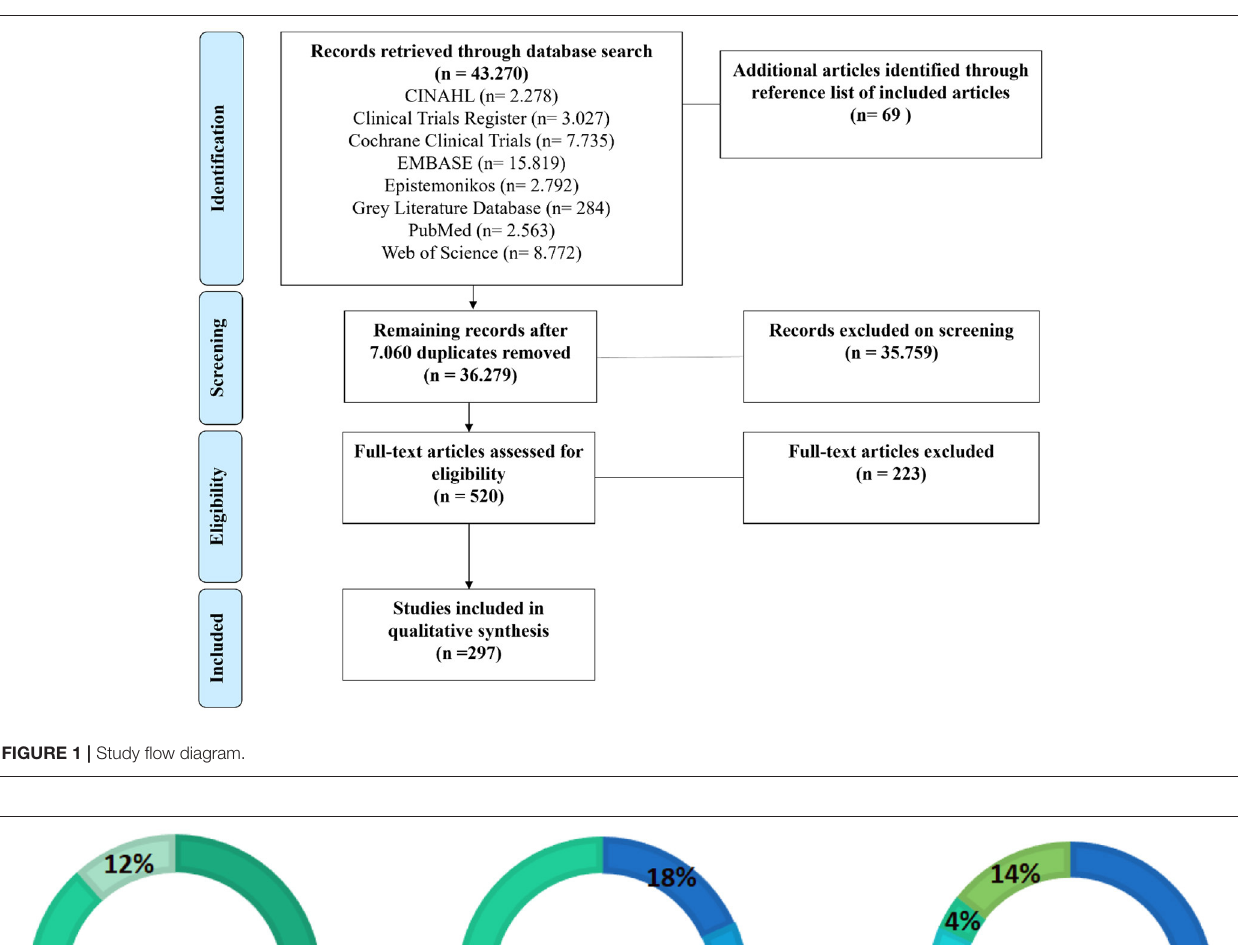
FIGURE 1 | Study flow diagram.